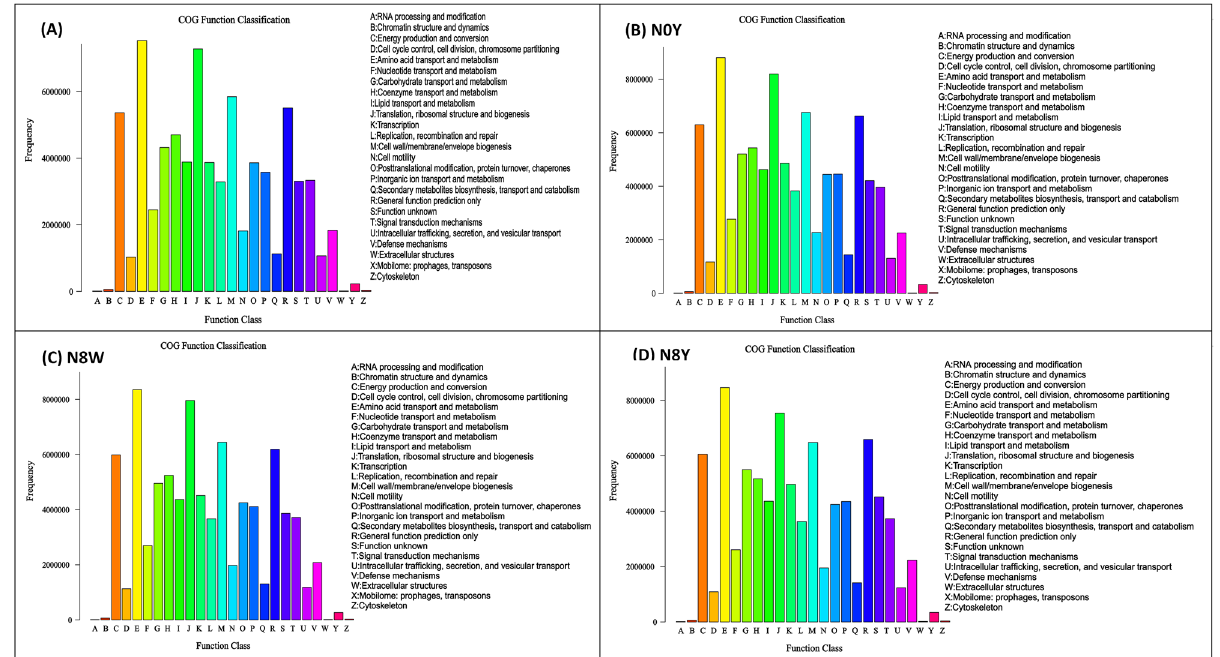
Figure 4. Functional analysis of inter-root soil microorganisms involving biological populations of sorghum under different nitrogen conditions.